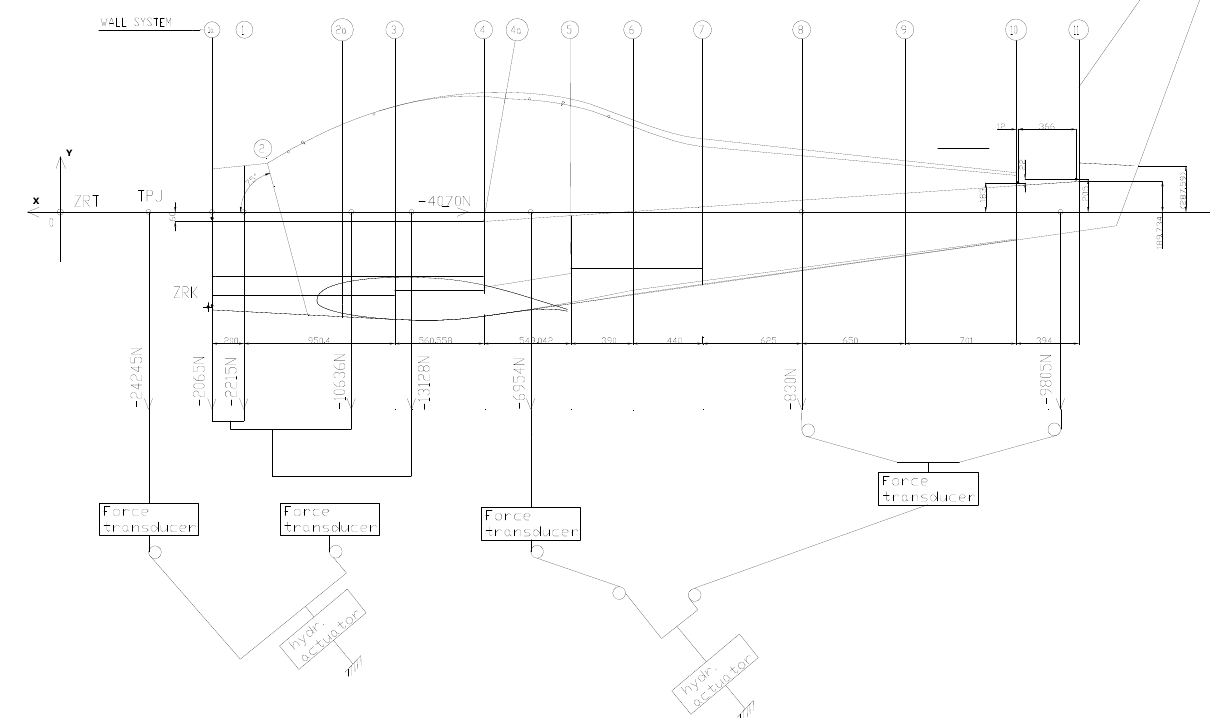
Fig 5. Proposed organization of the test – combination case